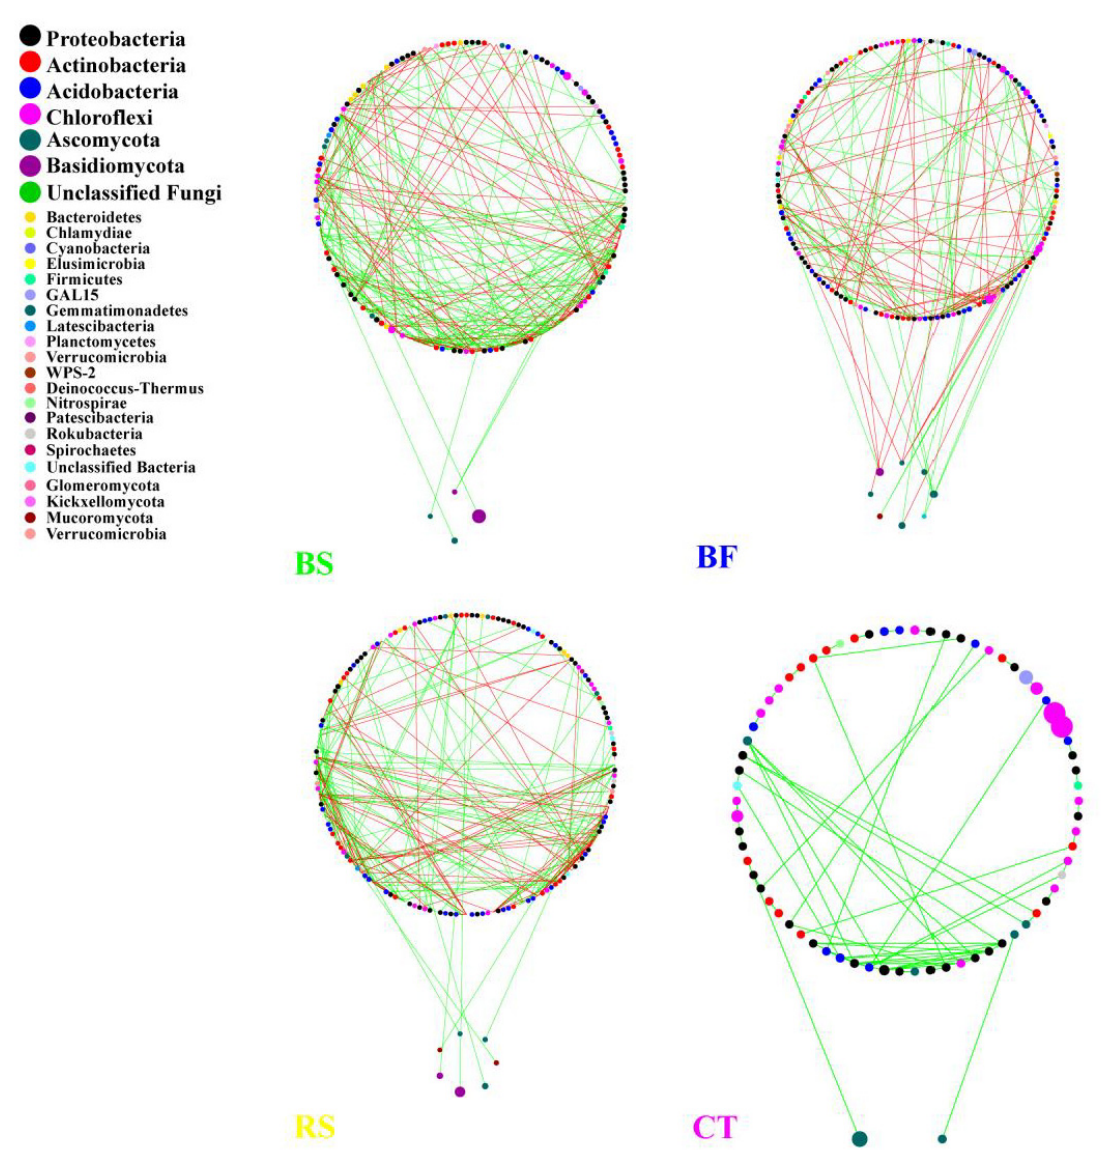
Figure 7. Molecular ecological networks of bacterial–fungal communities under different soil and water conservation measures. Green and red lines denote significant positive (Spearman correlation, p < 0.05, r > 0.8) and negative linear (Spearman correlation, p < 0.05, r < − 0.8) relationships, respectively. The size of the circles represents the relative abundance of bacteria or fungi.